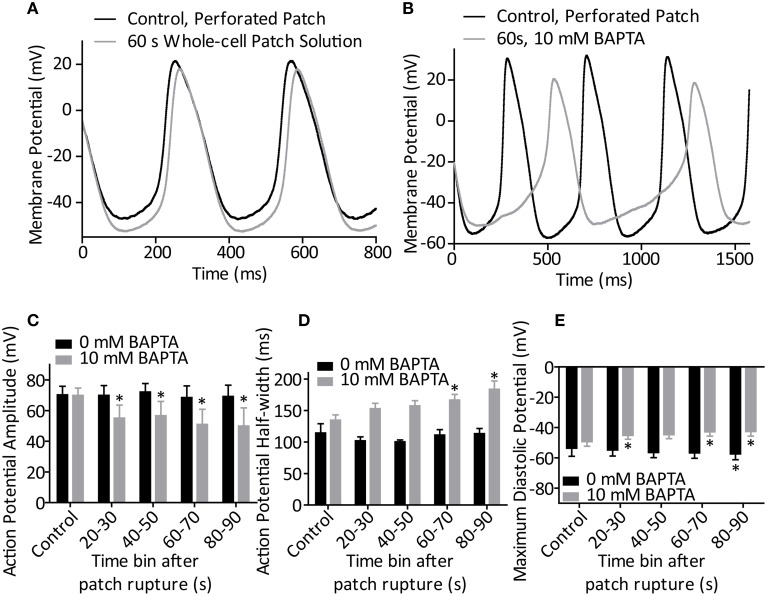
(A) Representative action potentials recorded during perforated patch control and 60 s after patch rupture with standard whole-cell patch solution (0 mM BAPTA). (B) Representative action potentials recorded during perforated patch control and 60 s after patch rupture to apply 10 mM BAPTA. (C) Effect of patch rupture on action potential amplitude over the course of 90 s. 10 mM BAPTA significantly reduced AP amplitude (p < 0.05, One-Way ANOVA with repeated measures). (D) Effect of patch rupture on half-width of the action potential. 10 mM BAPTA significantly lengthened the action potential half-width (p < 0.05, One-Way ANOVA with repeated measures). (E) Effect of patch rupture on most negative diastolic potential over the course of 90 s. 10 mM BAPTA significantly depolarized the MDP (p < 0.05, One-Way ANOVA with repeated measures) *Denotes significant difference from control, during perforated patch recording (p < 0.05 by post-hoc test with Dunnett's multiple comparison performed after One-Way ANOVA). n = 4 for 0 mM and n = 5 for 10 mM recordings.